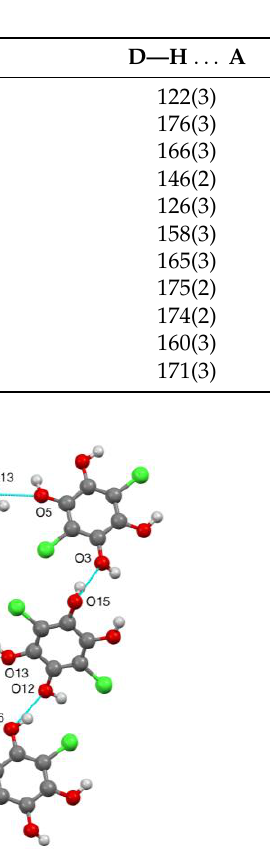
Figure 3. Hydrogen-bonding pattern for compound 1 with water molecules removed for clarity.